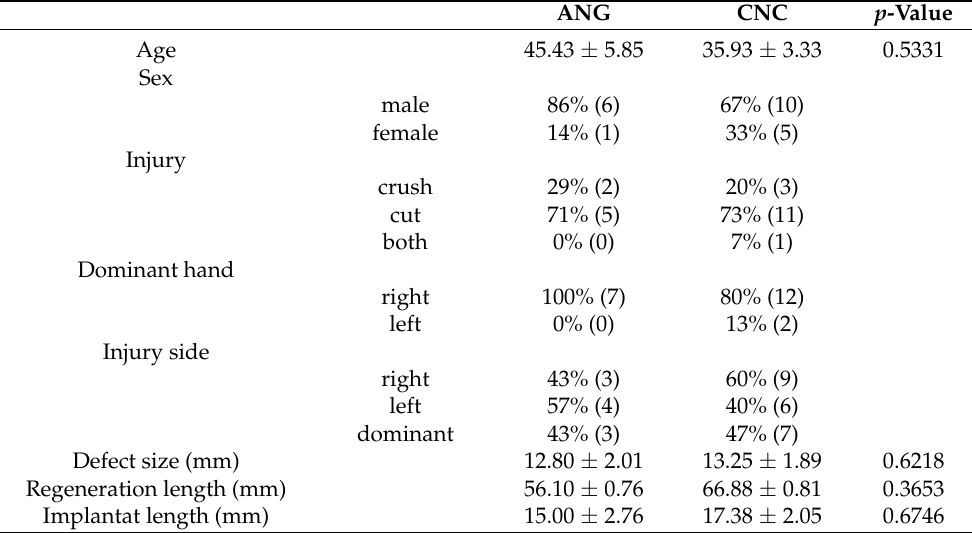
Table 1. Patient collective and qualitative analysis. Both groups showed no statistically significant differences in patient age, peripheral nerve defect distance, regeneration length (the distance between the proximal nerve lesion and the finger pulp), and implant length. CNC: chitosan nerve conduit; ANG: autologous nerve